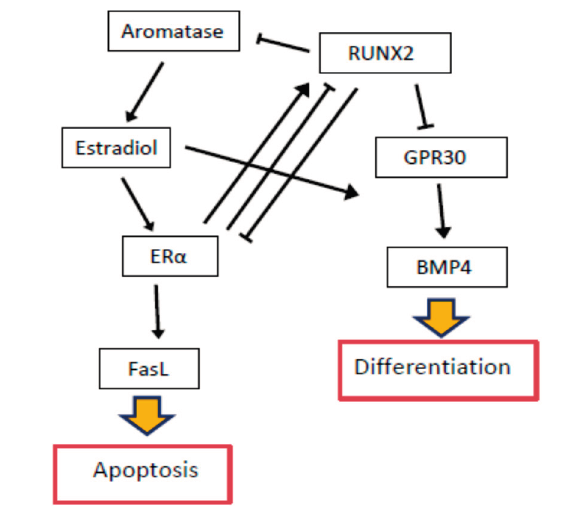
Figure 3. RUNX2 and estrogen signaling pathways in the control of cellular apoptosis and differentiation. Sharp arrows indicate positive, while blunt arrows—negative regulation. FasL: fas ligand; GPR30: G protein-coupled estrogen receptor; BMP-4: bone morphogenetic protein